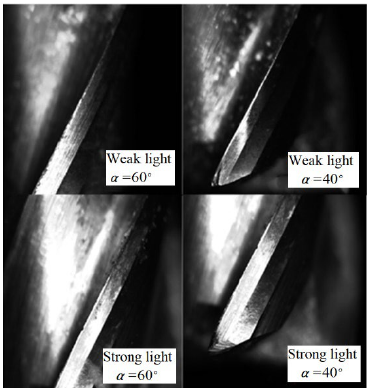
Figure 8. Different types of local end mill wear images under different parameters.